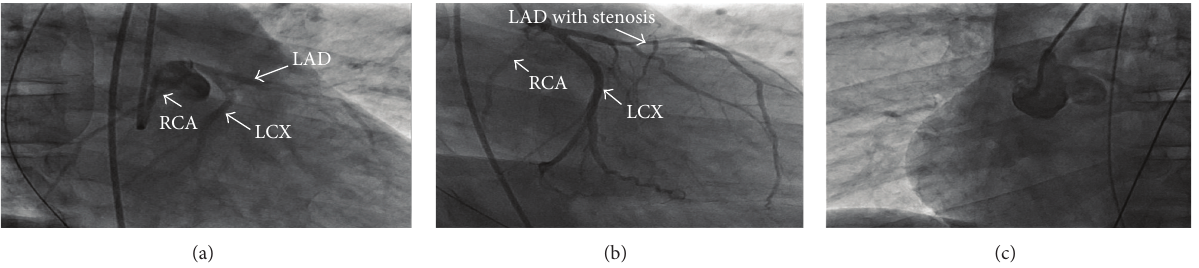
Figure 2: (a) Anomalous right coronary artery AP caudal projection with nonselective left coronary ostia angiogram. (b) Anomalous right coronary takeoff from left coronary artery in a RAO caudal projection of nonselective left coronary ostia angiogram. (c) Aortogram utilizing the JR4 catheter showing no separate right coronary